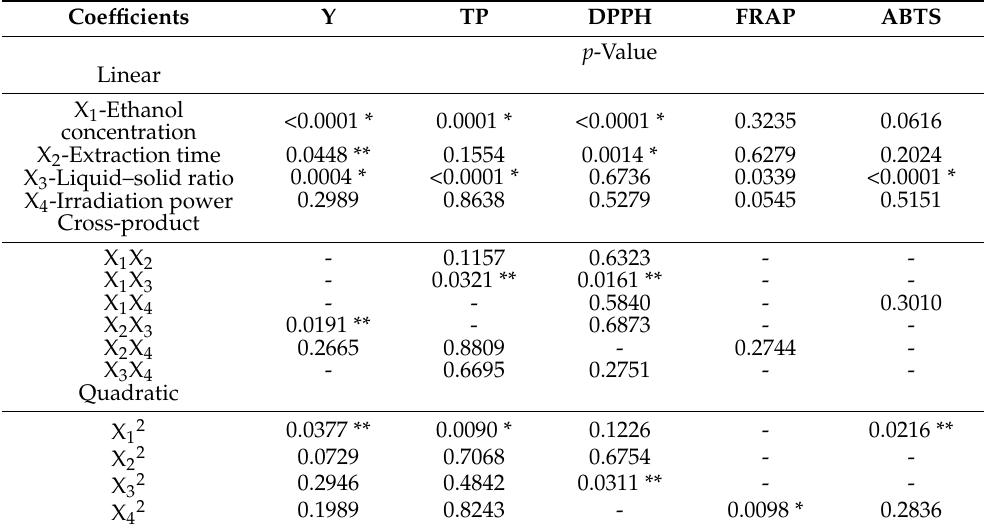
Table 2. Significance of linear, cross-product and quadratic terms on Y, TP, DPPH, FRAP and